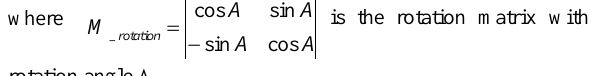
Figure 6. Direct transformation will flip intermediate images if